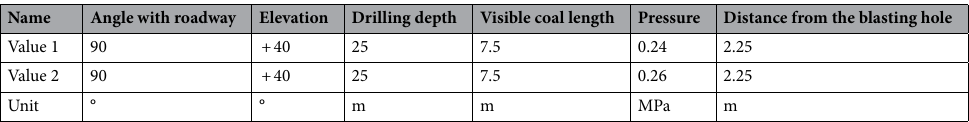
Table 4. Drilling parameters.